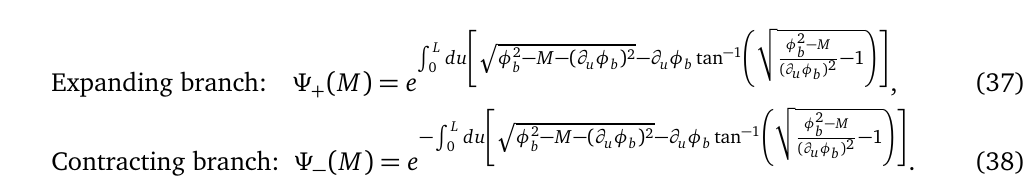
Figure 1: (a) We show the slicing we use for Euclidean JT gravity in asymptotically AdS which has disk topology (but not necessarily rigid hyperbolic metric). (b) Frame where the geometry is rigid EAdS with r increasing upwards and a wiggly boundary denoted by the 2 blue